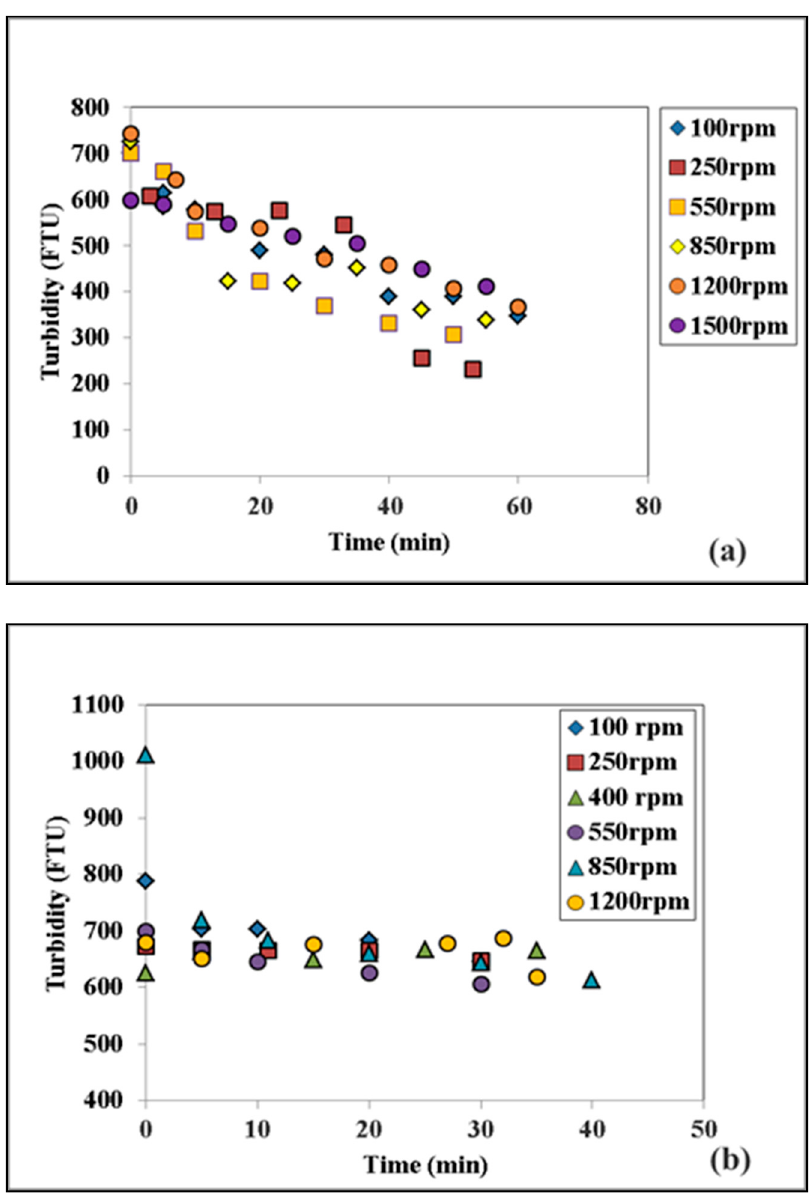
Figure 2. Textile WW turbidity variation in time at three different rotating speeds and a WW flow rate of ( a ) 15 L/h, ( b ) 25 L/h.